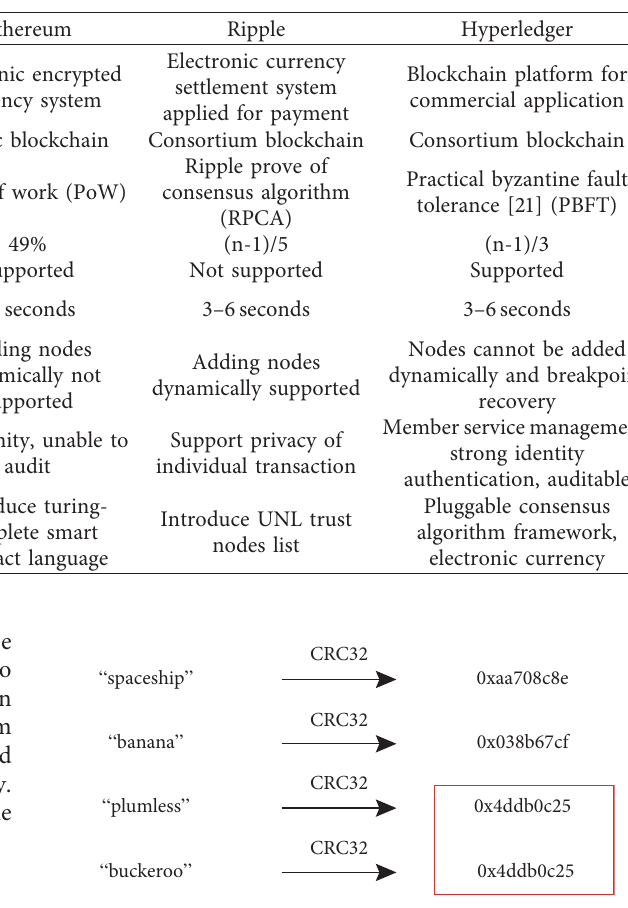
Table 1: Comparison of some blockchain architectures.